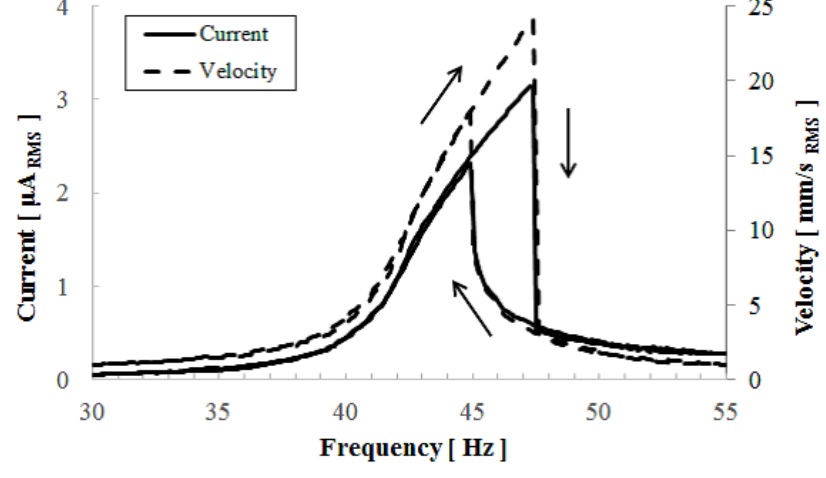
Figure 6. Measurement results of the short-circuit current and the vibration velocity of the cantilever as a function of external vibration